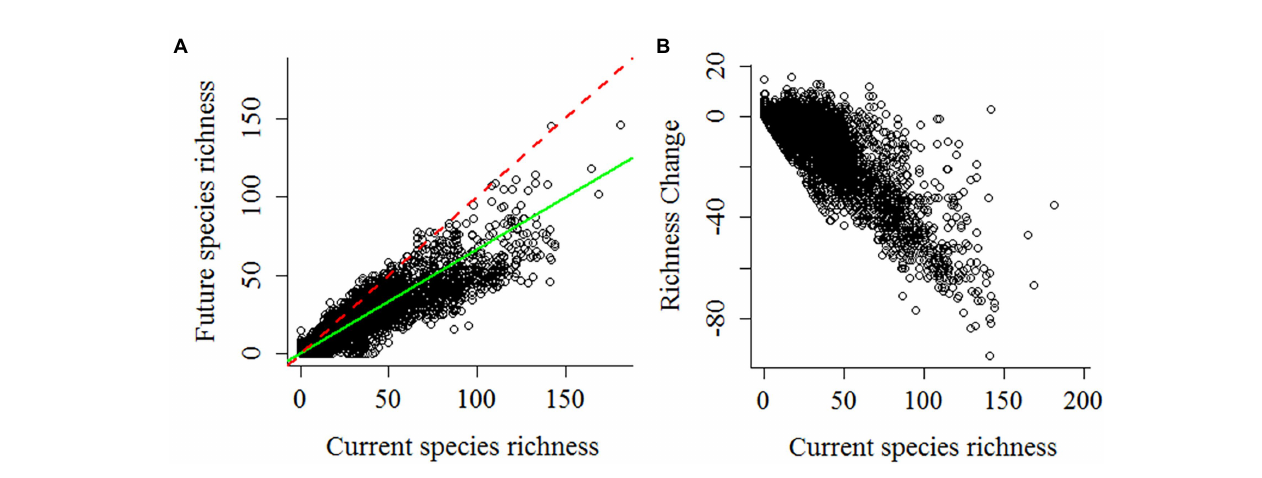
FIGURE 3 (A) Relationship between current and future richness. Red dashed line (intercept = 0 and slope = 1). Green solid line (intercept = 0; richness = 0.615). (B) change in richness with losses and gains in number of